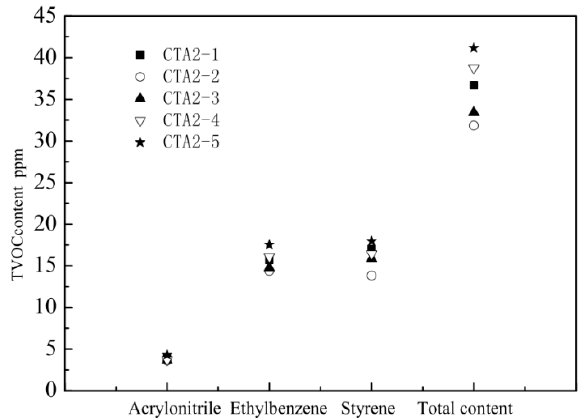
Figure 6. Influence of α -methyl styrene content on the amount of different VOC and on TVOC. The amount of CAT2-4 and CAT2-5 is 0.45 and 0.5 mol%,